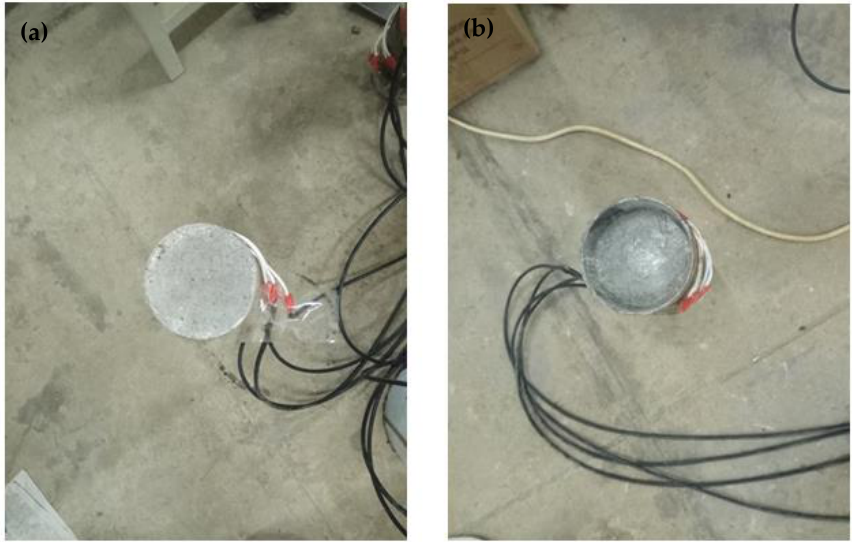
Figure 3. Test device system of CFST ( a ) loading system ( b ) data collection system.